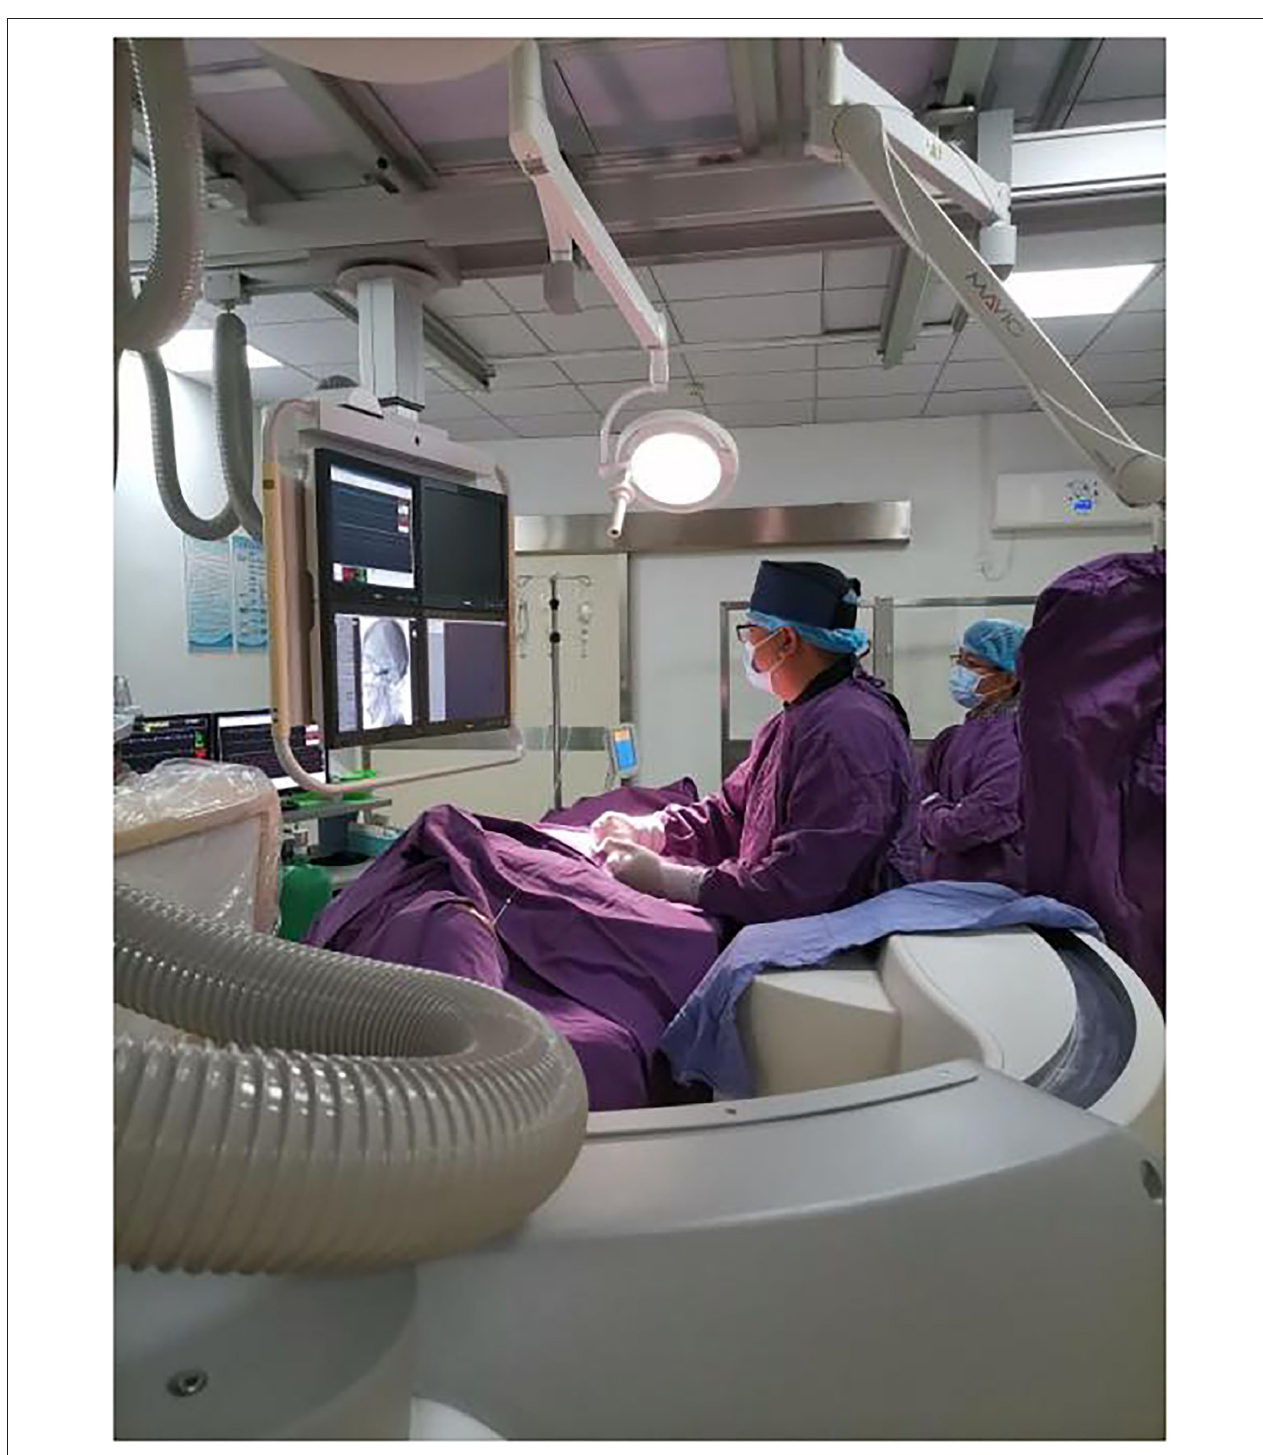
FIGURE 4 | The puncture process was guided under the direction of DSA.